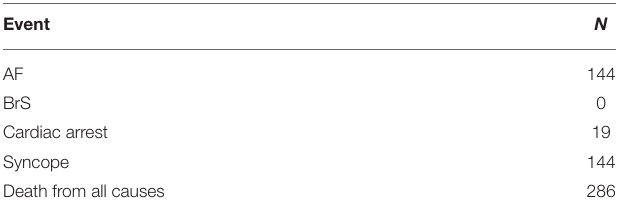
Frontiers in Physiology |